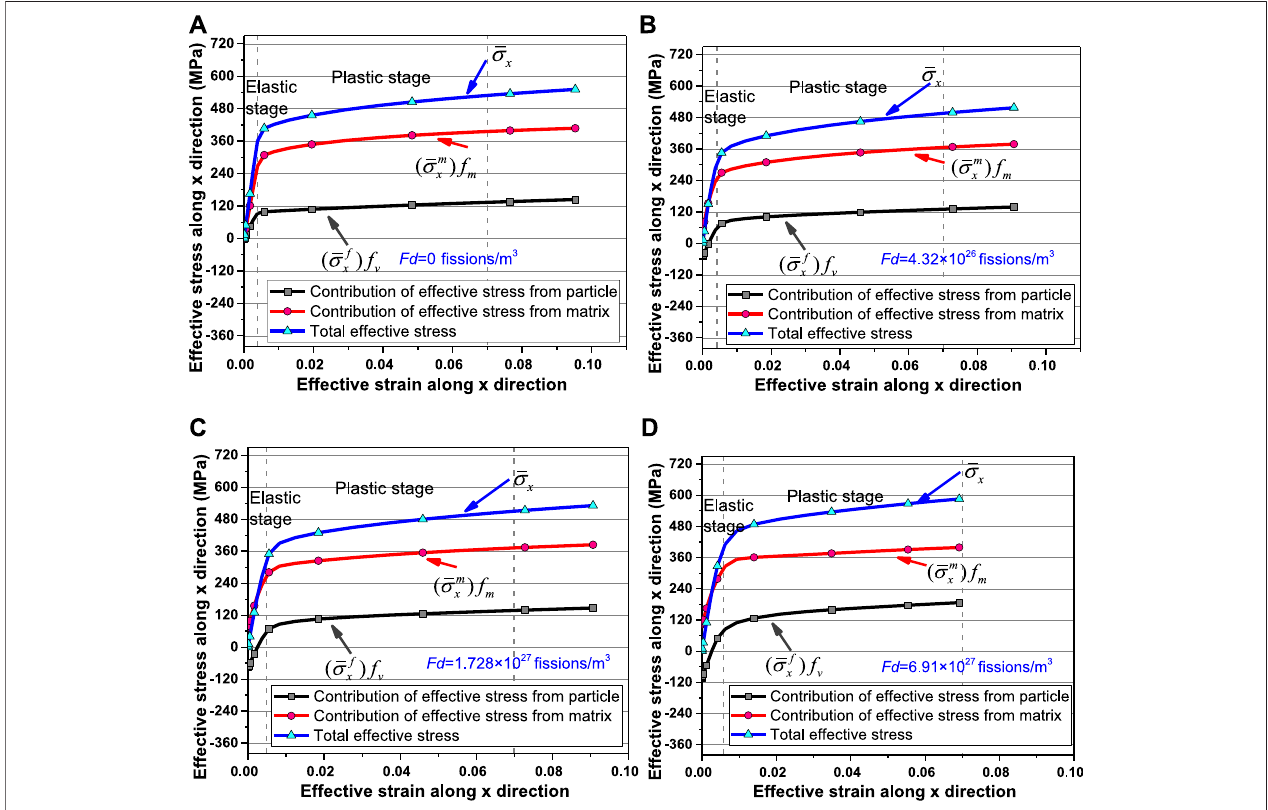
FIGURE 6 | Effective stress/strain curves and the effective stress contributions for the particle fi ssion density of (A) 0 fi ssions/m 3 , (B) 4.32 × 10 26 fi ssions/m 3 , (C) 1.728 × 10 27 fi ssions/m 3 , and (D) 6.91 × 10 27 fi ssions/m 3 .